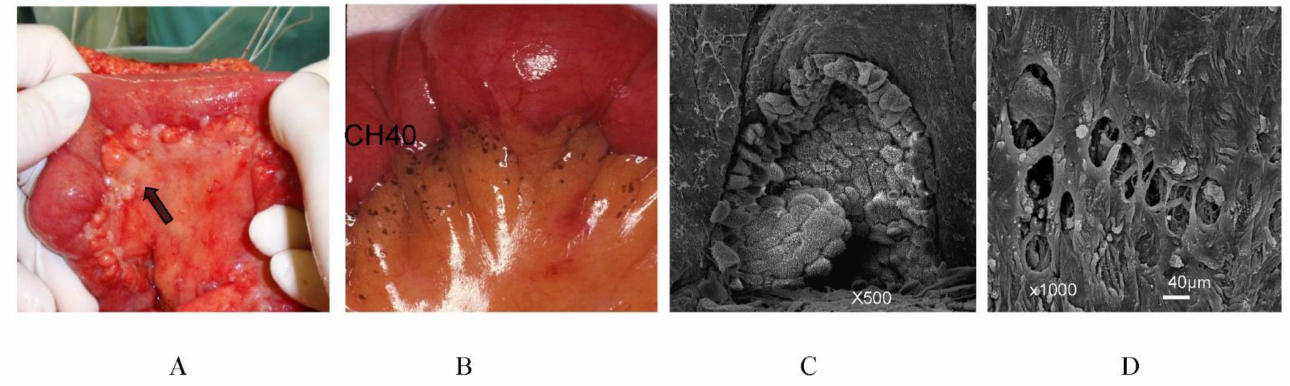
Figure 24. ( A ) Metastasis from gastric cancer on the small bowel mesentery. Metastatic nodules are found at the site of the mesenteric attachment to the small bowel. ( B ) CH44 intraperitoneally injected is present in similar sites of metastasis to those in ( A ). ( C ) Scanning electron micrography shows the omental milky spots (oval shaped-structure) covered with cuboidal mesothelial cells. Between the cuboidal mesothelial cells, stomata-like holes are observed. ( D ) After maceration with KOH, the macula cribriformis with holes is detected.